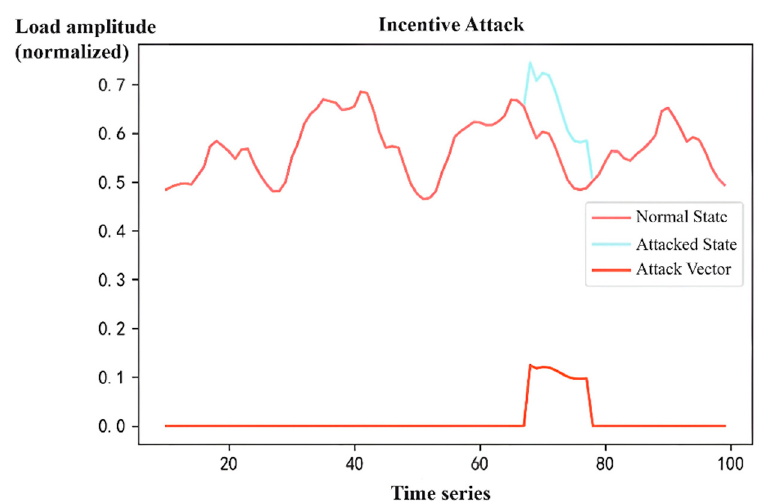
Figure 3. Incentive attack.